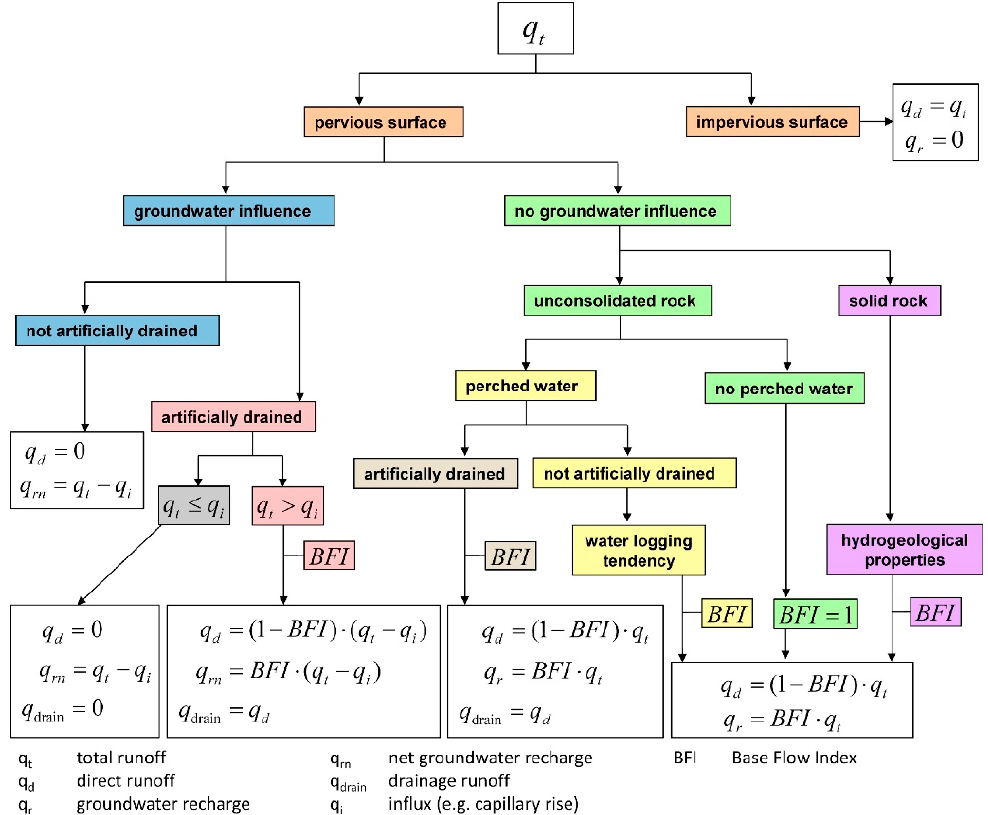
Figure 3. Base flow index method for total runoff-separation in mGROWA [11].